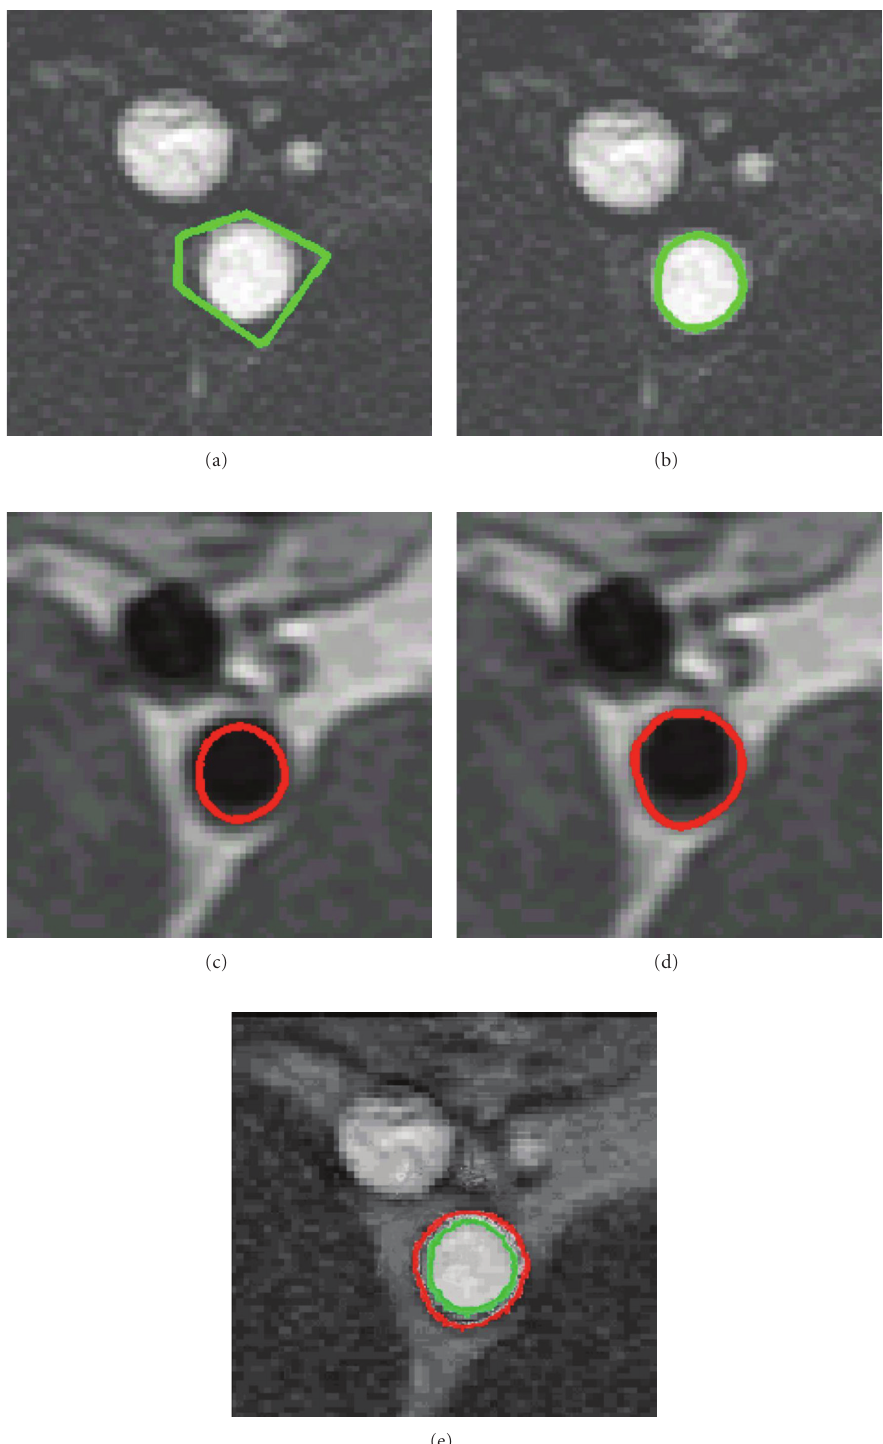
Figure 4: Example of the GVF snake algorithm. (a): A coarse approximation is drawn in the first M2DI slice. (b, c) The final position of the snake in this slice (b), corresponding to the inner boundary of the vessel wall, is transferred to the next M2DI slice and also to the first PDW slice (c). (d, e): The final position of the snake in this image (d) represents the outer border of the vessel wall, and the area between the two snakes (e) is a measure of the wall